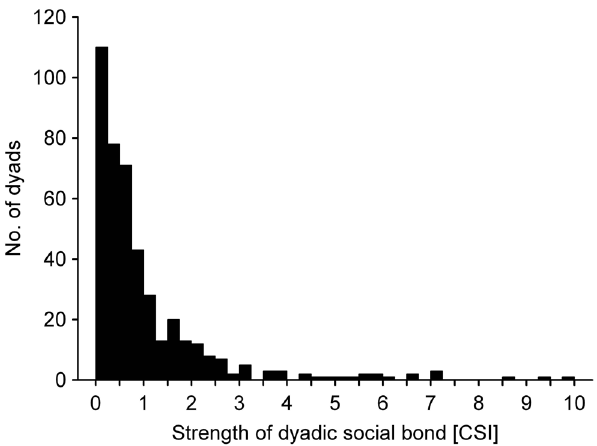
Figure 1. Distribution of the strength of dyadic social bonds measured as the composite sociality index (CSI) between females in a group of captive rhesus